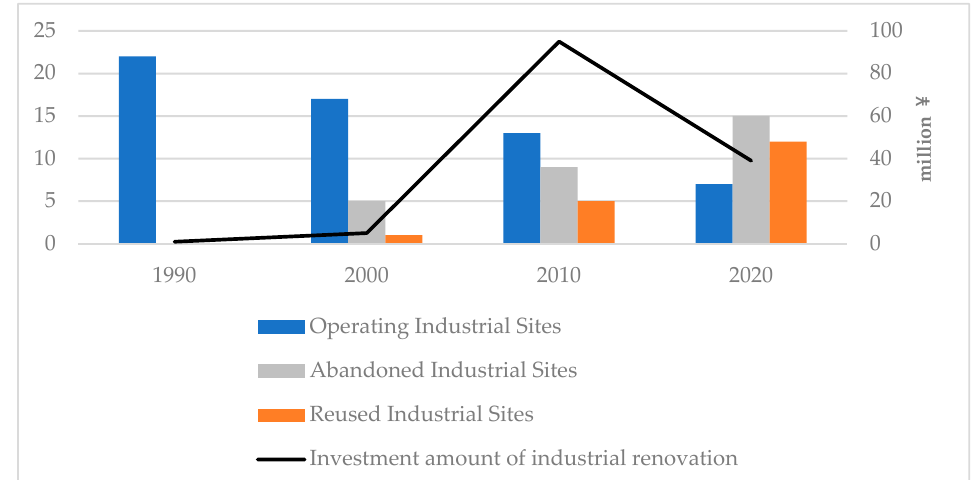
Figure 19. The change in the relationship between the operation state of capital-intensive industries and the investment amount of industrial renovation over time (Figure source: own drawing; data from: [83]).